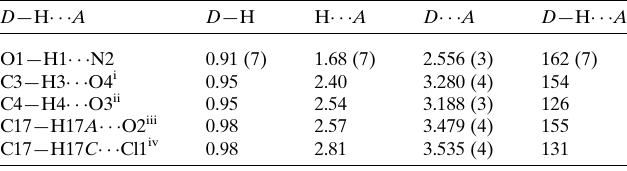
Table 3 Hydrogen-bond geometry (A˚ , (cid:4) ) for (II).